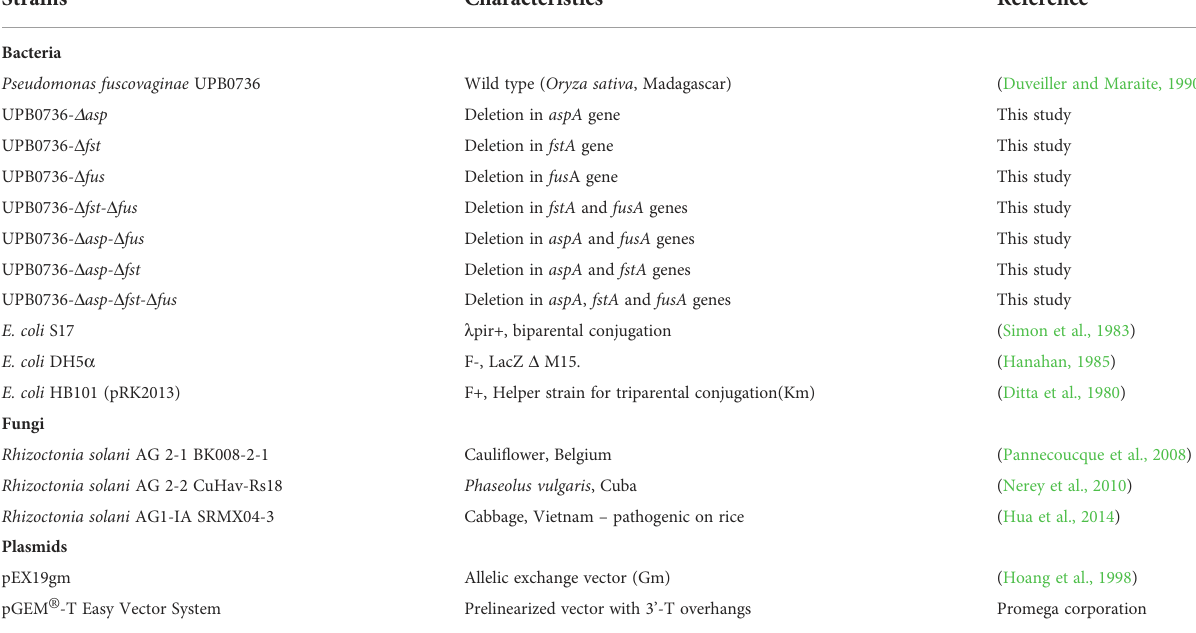
TABLE 1 Microbial strains and plasmids used in this study and their main characteristics. Strains